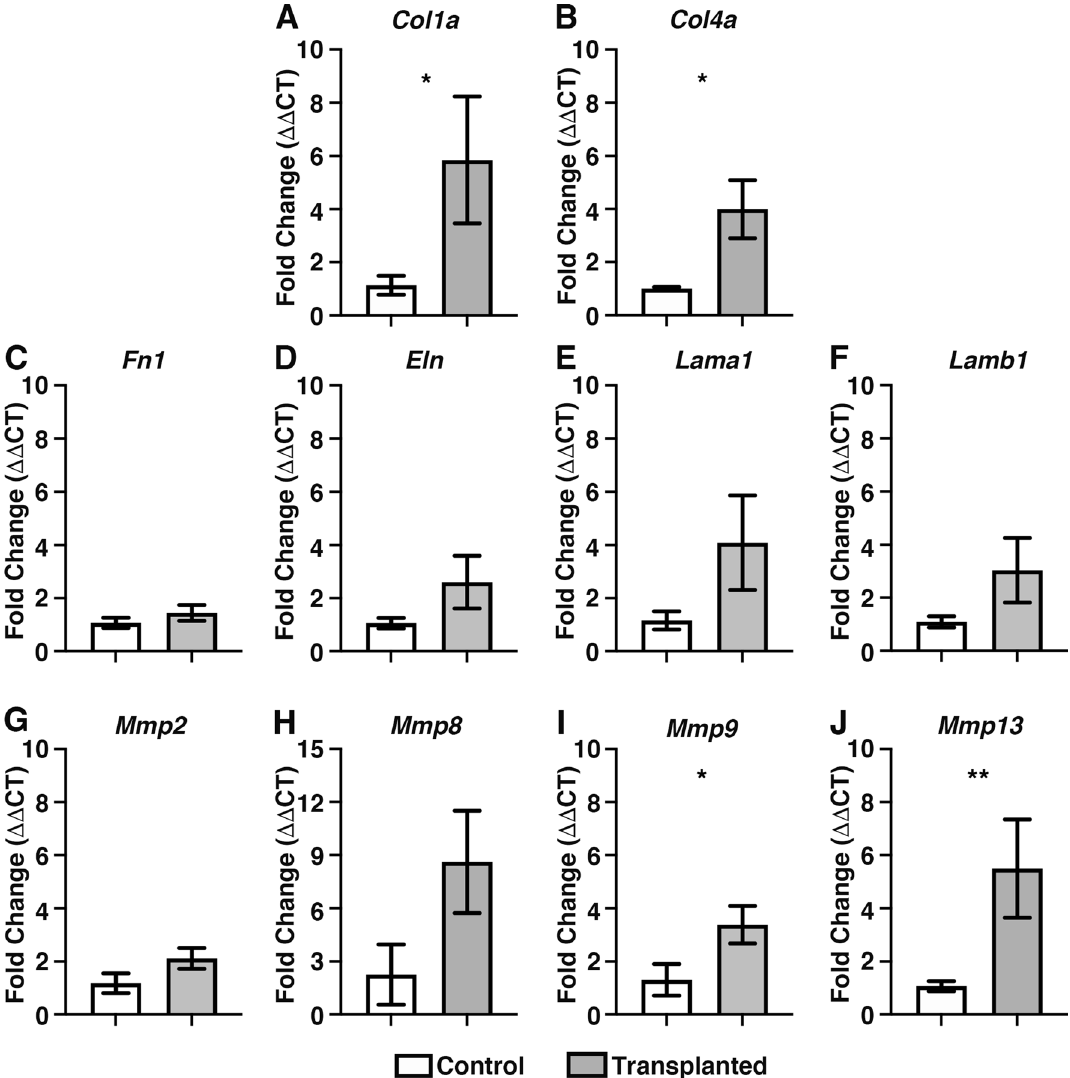
Figure 7. Donor cell integration leads to increased expression of collagen and Matrix metalloproteinases. ( A – F ) Summary data showing mRNA fold change for ECM-related and matrix metalloproteinase genes: ( grey bars ): Collagen 1a ( Col1a ; A ), Collagen 4a ( Col4a ; B ) Fibronectin 1 ( Fn1 ; C ), Elastin ( Eln ; D ), Laminin a1 ( Lama1: E ), Laminin b1 ( Lamb1 : F ), Matrix metalloproteinase-2 ( Mmp2 ; G ), Matrix metalloproteinase-8 ( Mmp8 ; H ), Matrix metalloproteinase-9 ( Mmp9 ; I ) and Matrix metalloproteinase-13 ( Mmp13 ; J ) 21-days after ex vivo transplantation compared to non-transplanted control ( white bars ) tissues. Error bars represent mean ± s.e.m. n = 4 for each gene examined. * P ≤ 0.05, ** P ≤ 0.01 comparing ΔCT values by Welch’s